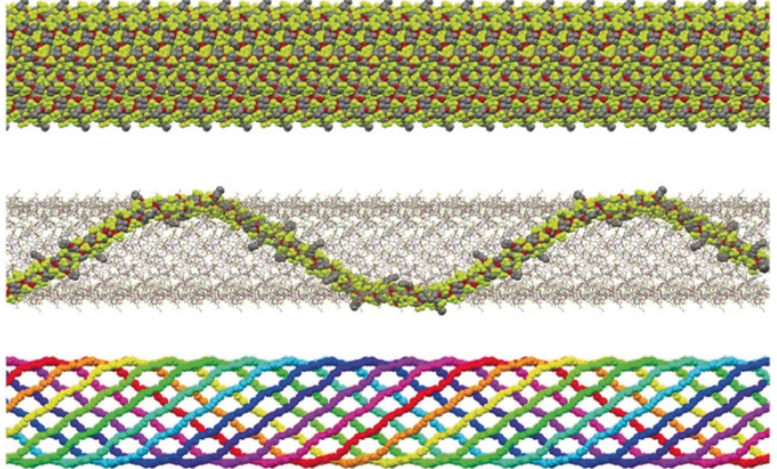
Figure 7. The supramolecular nanotube formed by [Tb(hfac) 3 NIT-O-Hexyl] n chains, showing ( top ) all atoms; ( middle ) one chain; ( bottom ) magnetic backbones only of 11 curled chains forming one nanotube. Reprinted from [129], copyright 2020, with permission from Wiley.